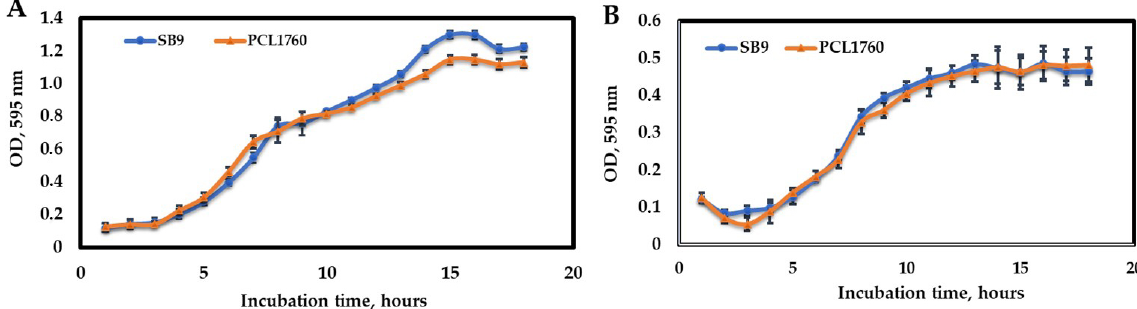
Figure 4. Growth curve comparison of P. putida SB9 and PCL1760 in a rich LB medium ( A ) and a basal medium ( B ). Data are represented as mean ± SD. basal medium ( B ). Data are represented as mean ±